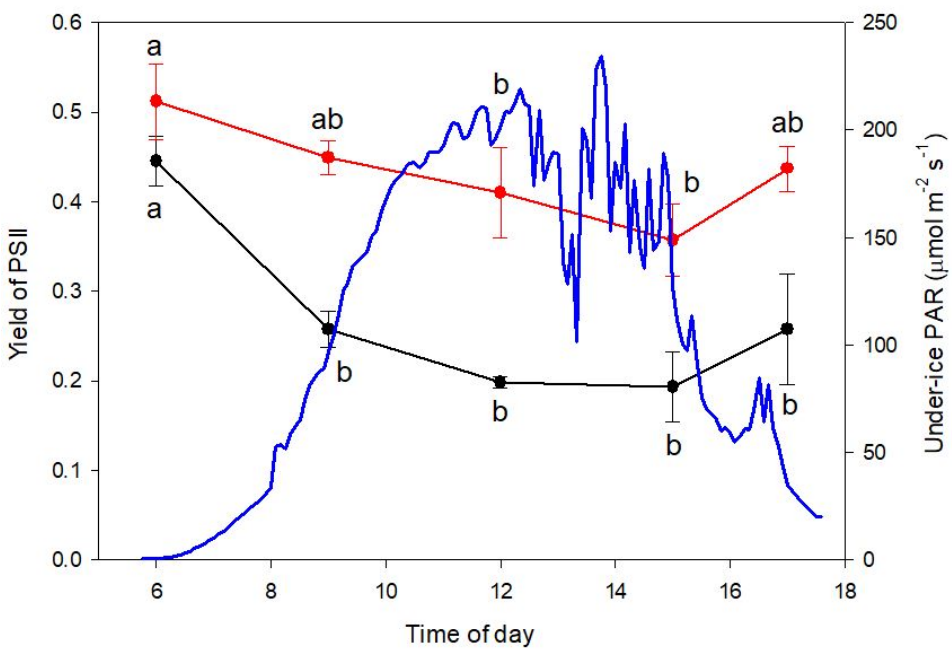
Figure 6. Diel cycles in yield of PSII for sea ice algae on Day 78 after loss of snow cover on fjord. Black line shows Φ PSII measured immediately after collection by Imaging-PAM fluorometry, red line shows Φ PSII_max after subsequent thawing in dark measured by Phyto-PAM fluorometry. Mean values ± 1SD, n = 3. Significant differences between time points at p < 0.05 (repeated-measures ANOVA, post hoc Bonferroni tests) shown for each curve by different letters adjacent to symbols. Blue line shows continuous monitoring of irradiance as photosynthetically active radiation (PAR) immediately under ice.